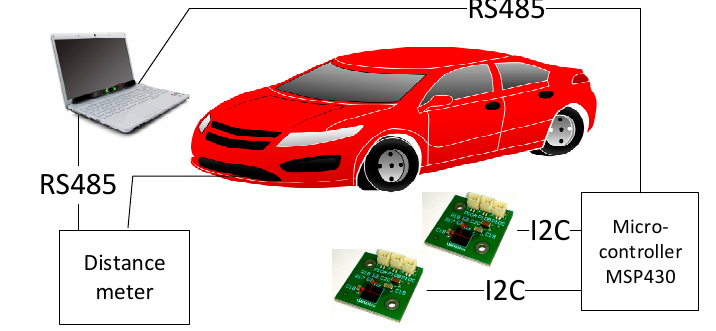
Figure 1. Experiment structure.